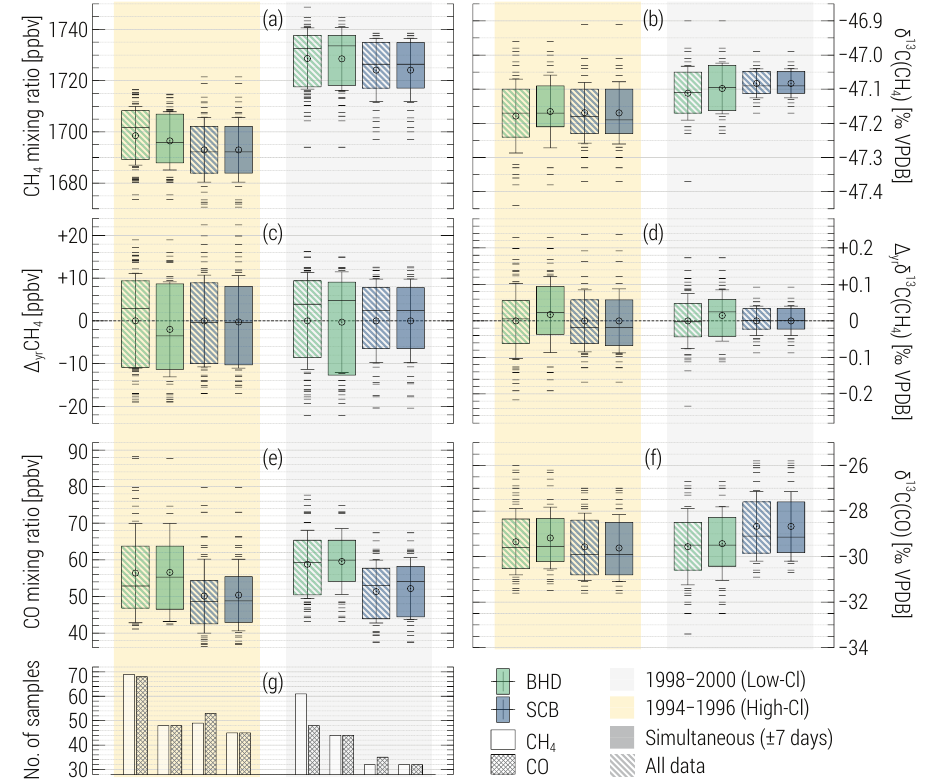
Figure 1. Statistics on the CH 4 and CO mixing and 13 C / 12 C ratios observed at Baring Head (BHD) and Scott Base (SCB) throughout the high-Cl (HC, orange shaded) and low-Cl (LC, grey shaded) periods hypothesised by Allan et al. (2007) (see text for details). Panels (c, d) show statistics on the anomalies with respect to the annual averages (denoted with “ (cid:49) yr ”). Panel (g) displays the number of samples in each subset. The full time series of the data are shown in the Supplement (Fig. S2). Boxes and whiskers present the median and interquartile ranges and ± 1 σ (of the population) of the data. Circles and minus symbols denote the averages and samples falling outside ± 1 σ . Solid boxes denote the subset of data when CH 4 and CO samples were taken simultaneously (up to 7 days apart); hatched boxes refer to all